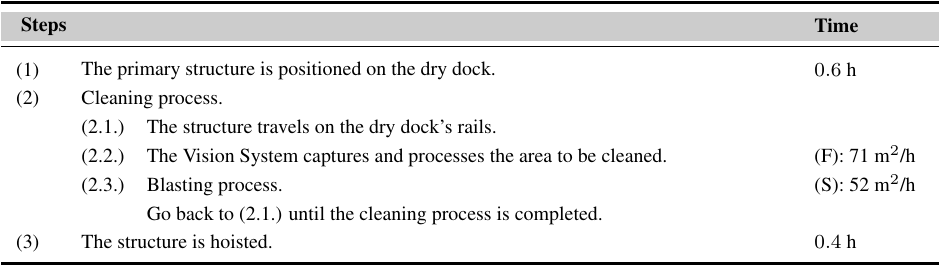
Table 4. Performance of the cleaning procedure using the HPSISC system.